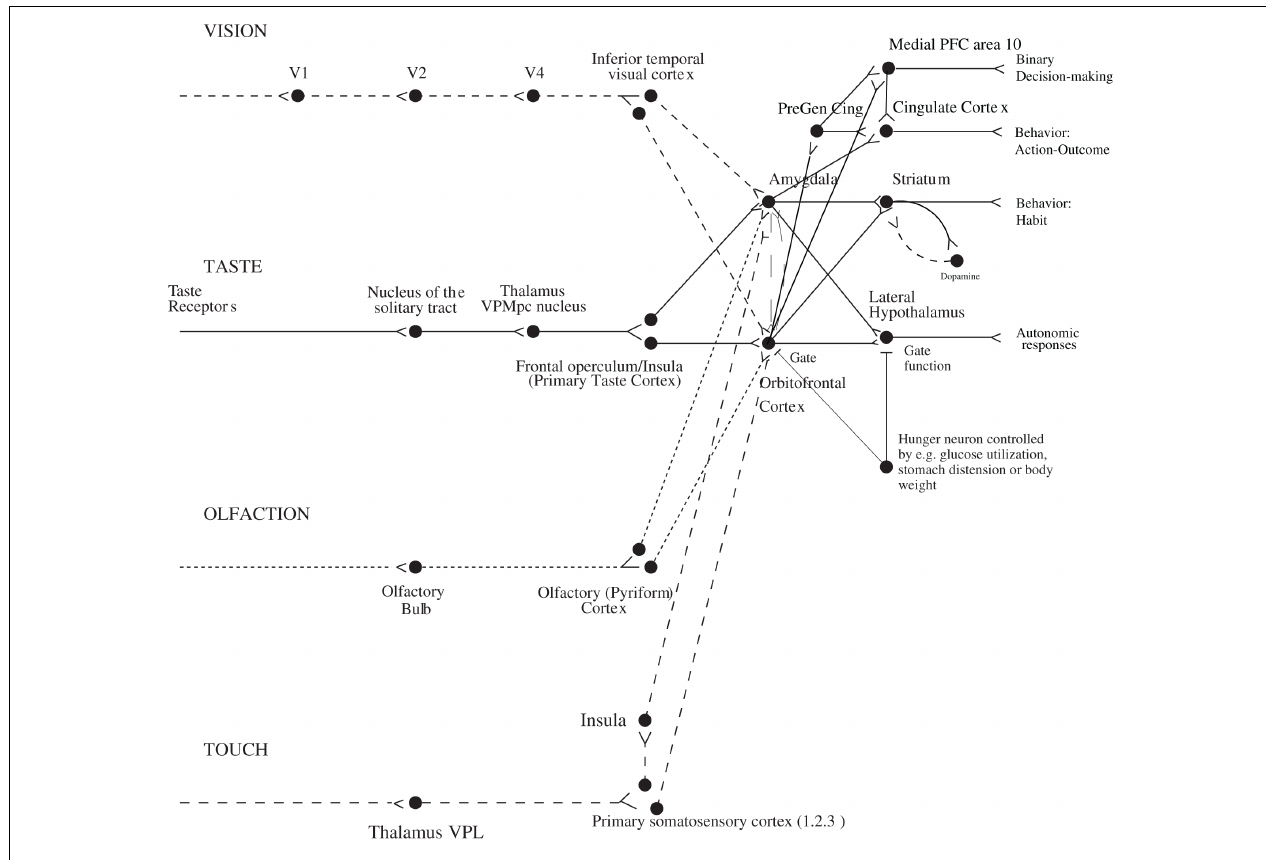
produce effects when hunger is present (Rolls, 2005).The column of brain regions including and below the inferior temporal visual cortex represents brain regions in which what stimulus is present is made explicit in the neuronal representation, but not its reward or affective value which are represented in the next tier of brain regions, the orbitofrontal cortex, and amygdala, and in areas beyond these. Medial PFC area 10, medial prefrontal cortex area 10;VPMpc, ventral posteromedial thalamic